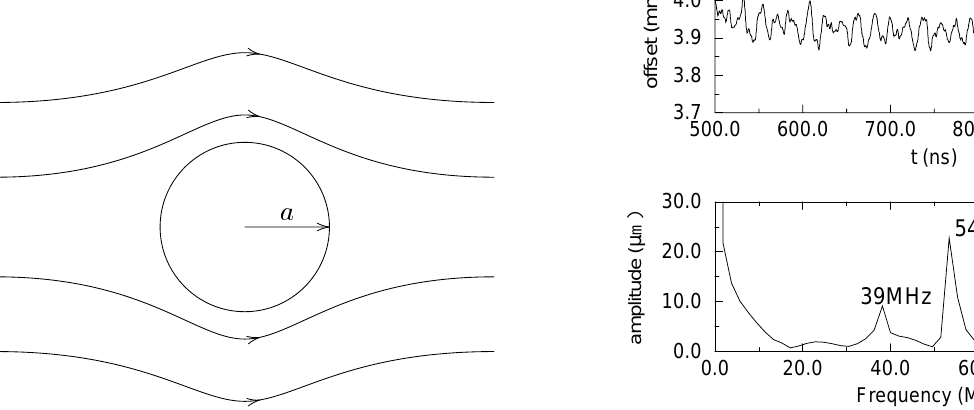
FIG. 10. Beam transverse displacement vs time is plotted on a magnified scale in (a). The Fourier transform is shown in